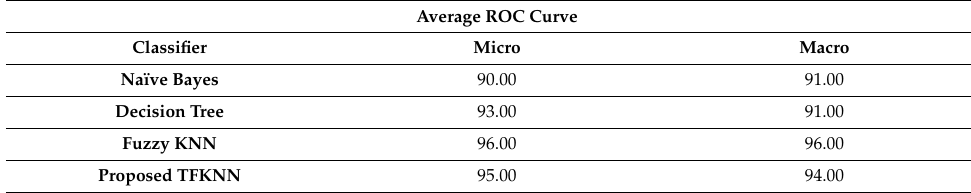
Table 10. Micro- vs macro-average ROC curve.